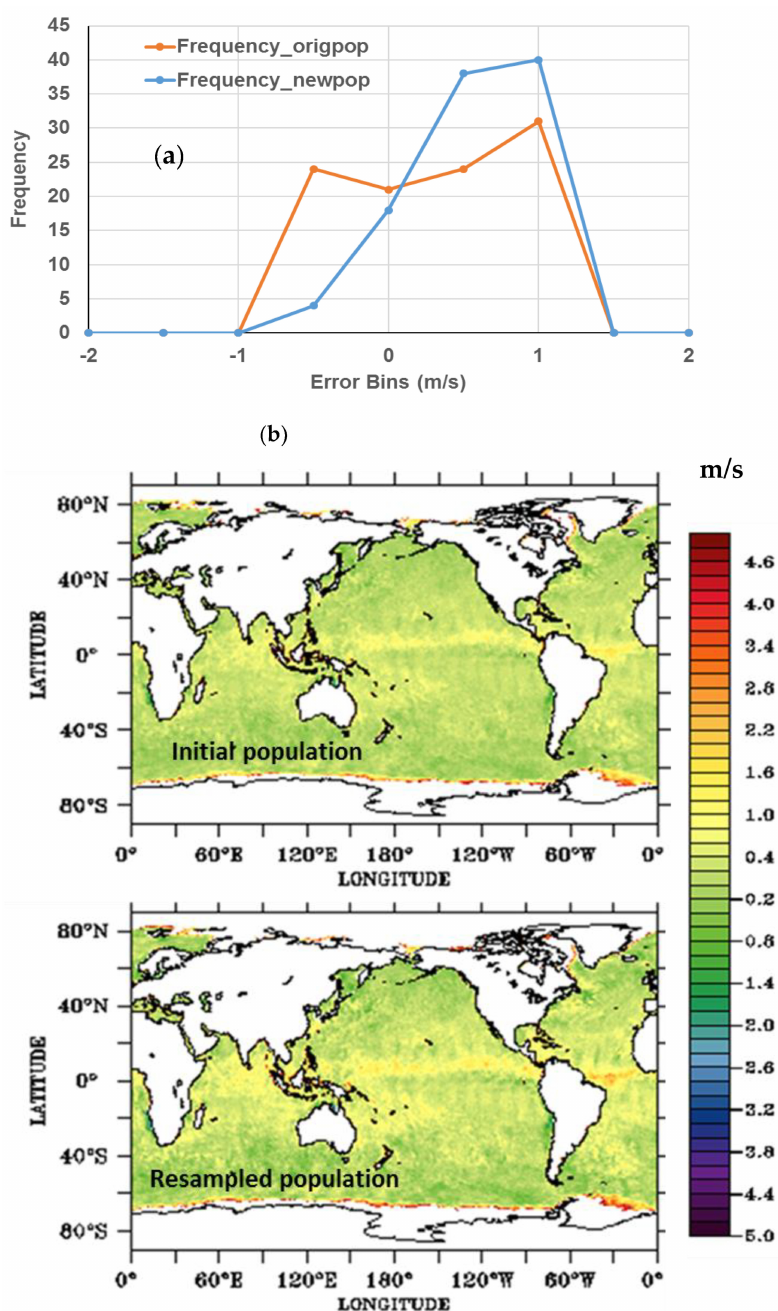
Figure 5. ( a ) Histogram of the bias in initial and final population. ( b ) mean perturbation in initial population (top) and same in resampled population (bottom) on 31 May